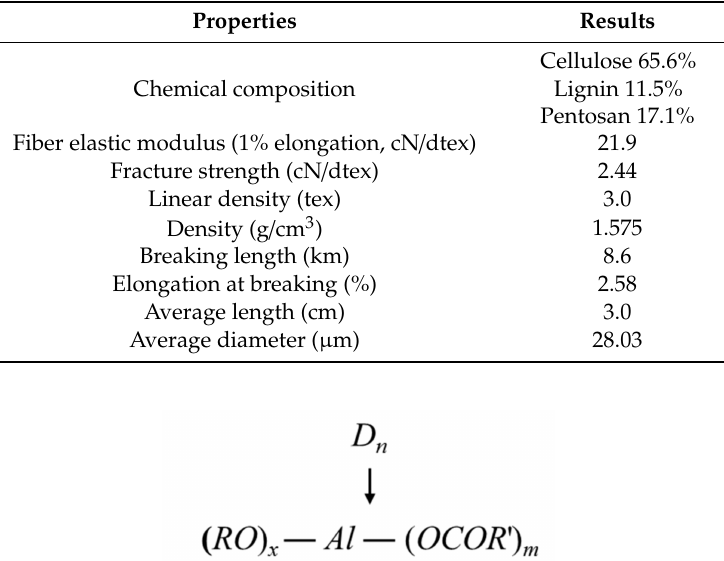
Figure 2. Chemical structure of aluminate ester (D n : dibutyl phthalate / dioctyl phthalate; RO: isopropyl group; OR’: isopropanol ester